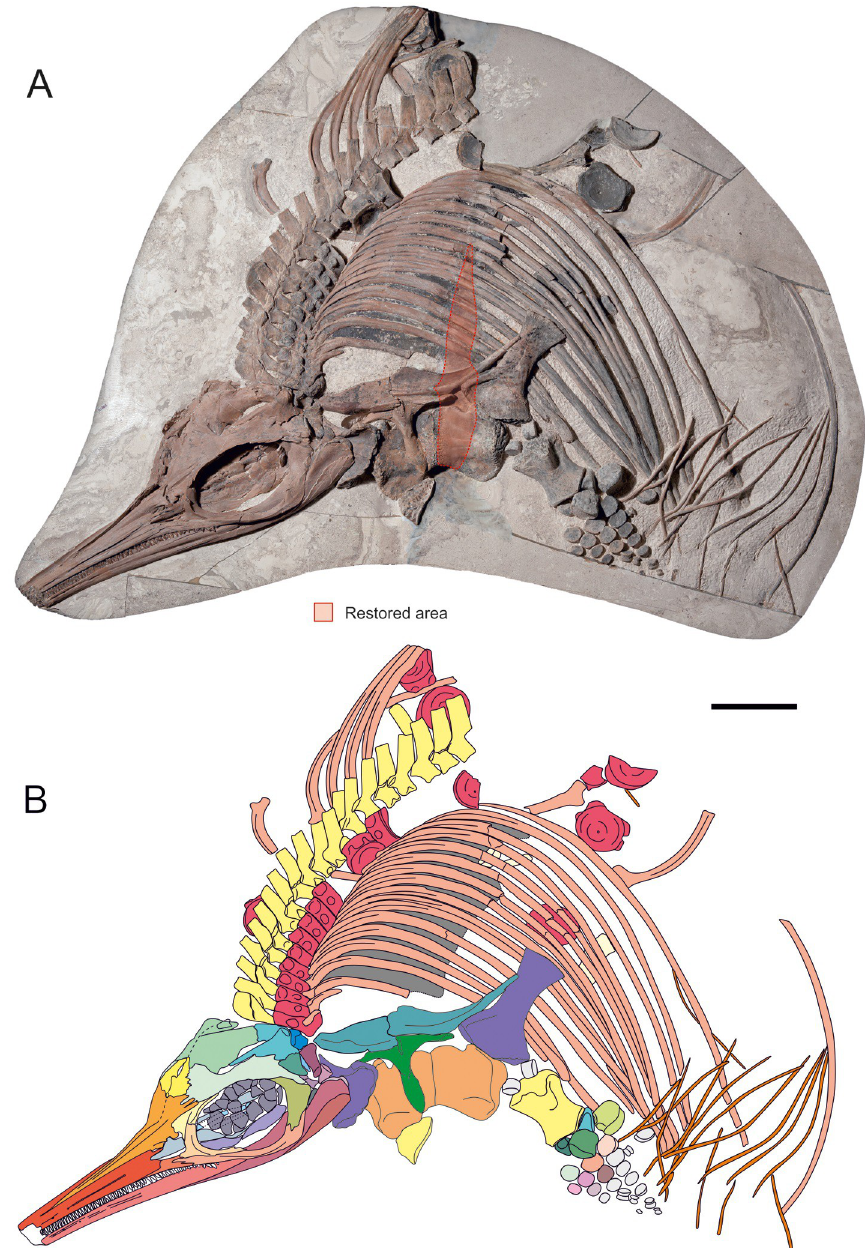
Fig 4. Anterior portion on the main block of Thalassodraco etchesi , MJML K 1885. A, photograph showing area restored during preparation. B, interpretive drawing of anterior portion of the skeleton. Scale bar represents 300 mm. Photograph used by permission of the Etches Collection under the CC BY 40 license, original copyright